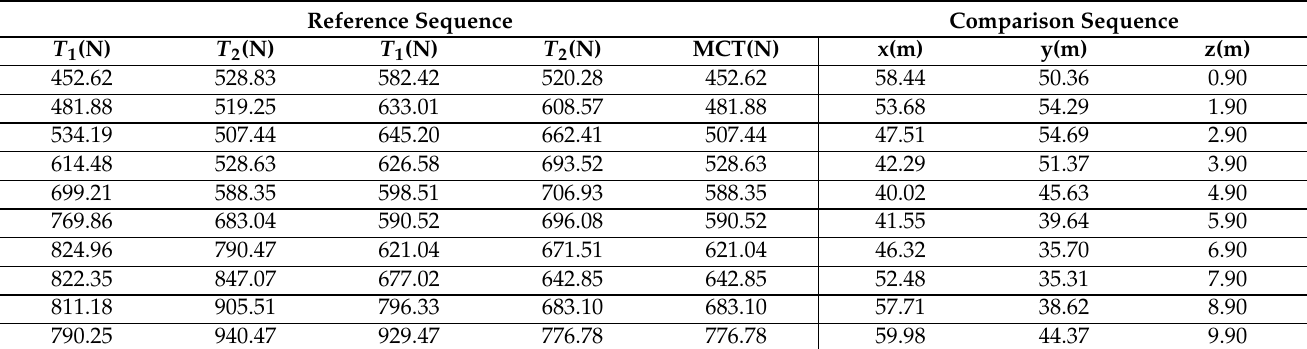
Table 2. Original data of cable tensions and positions of the camera